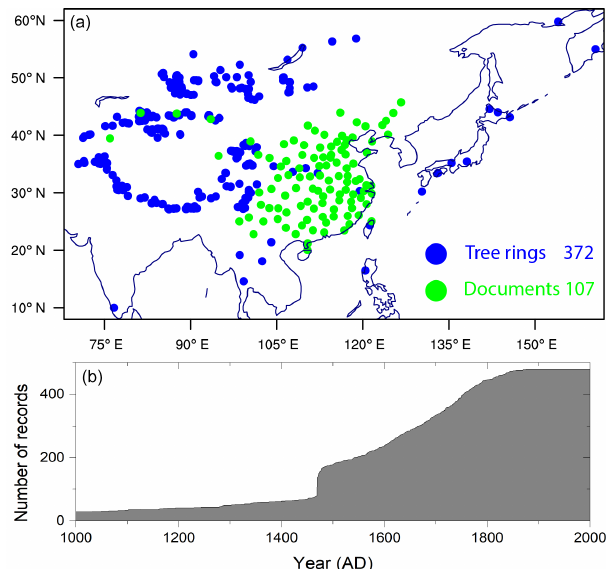
Figure 1. Map showing the locations of proxy records (a) and plot of the number of proxy records for each year (b)